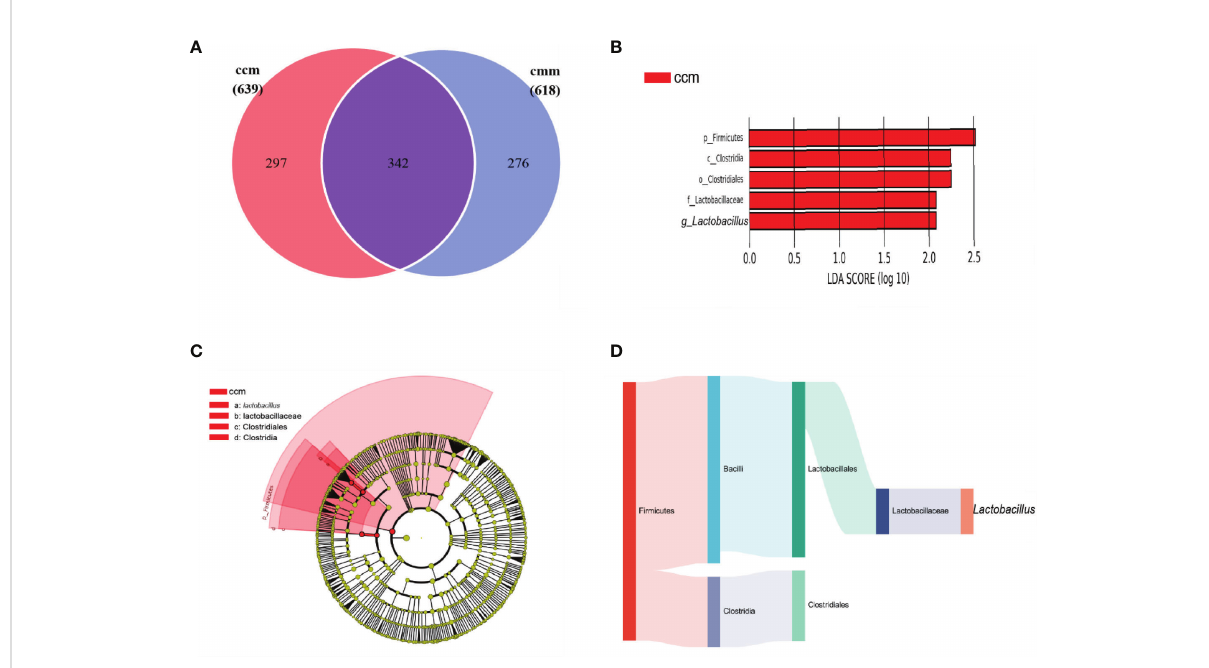
FIGURE 5 The characteristics of intestinal mucosal microbiota of mice. (A) Venn diagram. (B) LDA scores Chart. (C) Cladogram diagram. (D) Sankey diagram (From left to right are phyla, class, order, family, genus). ccm group, control group; cmm group, model group ( n =